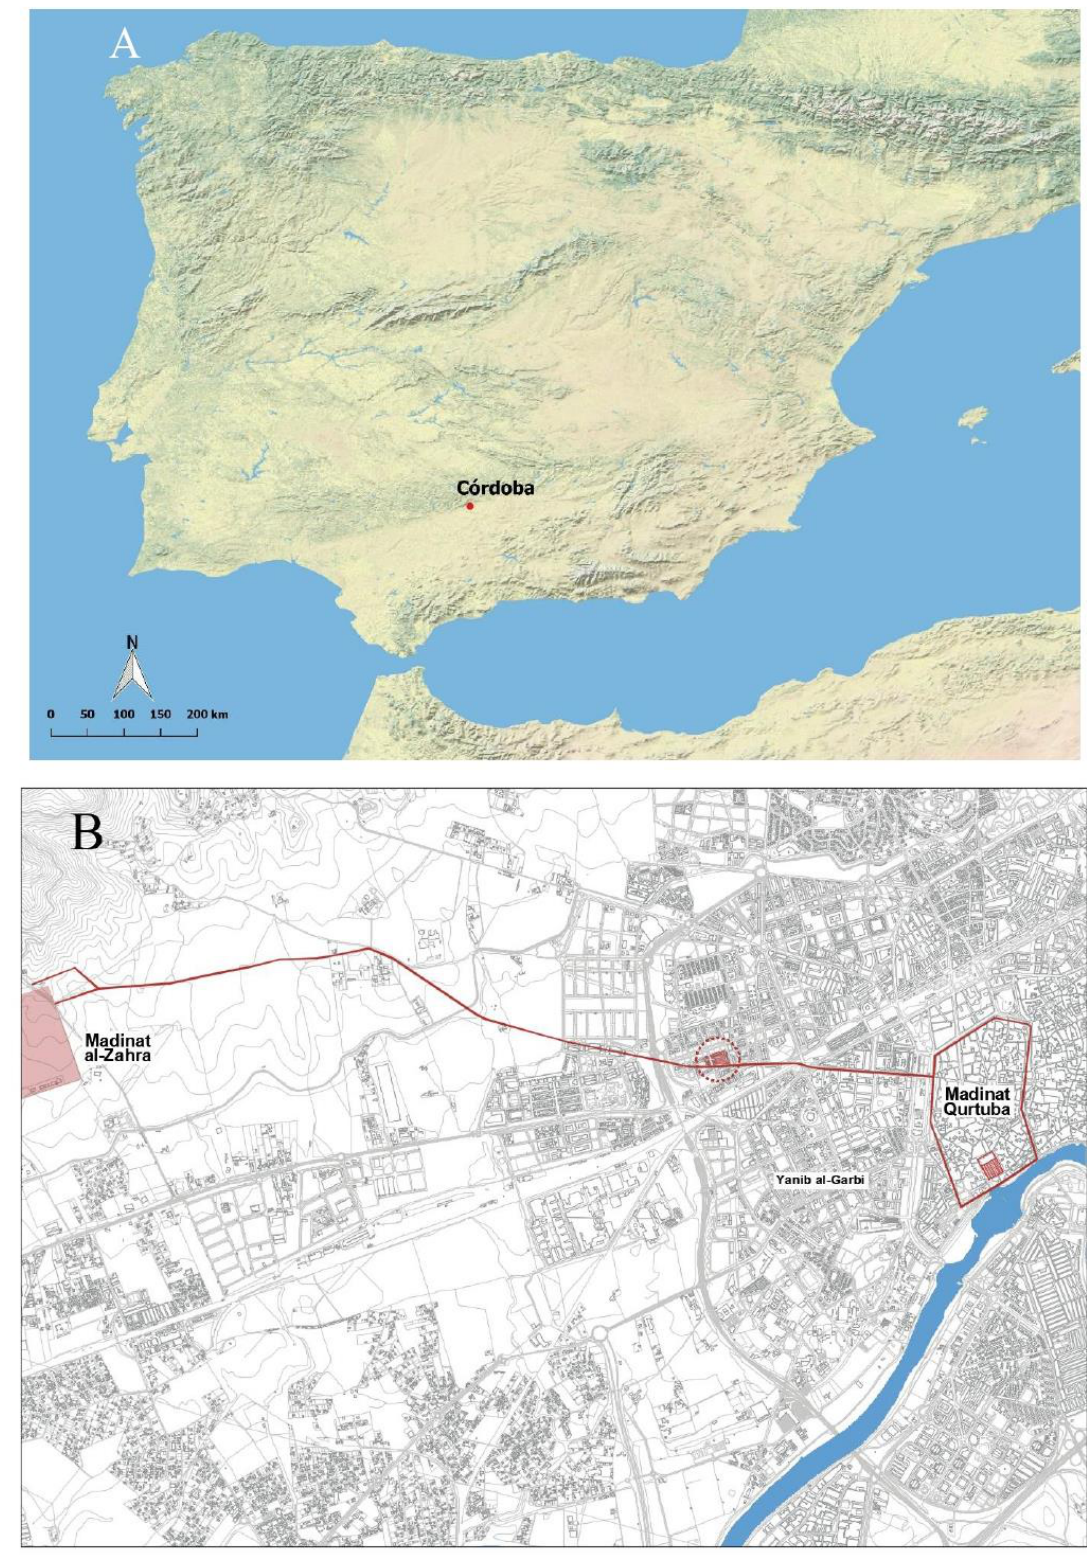
Figure 1. Location map of Córdoba ( A ). Location of the excavation area against the plan of modern Córdoba (Source: Instituto de Estadística y Cartografía de la Junta de Andalucía). In red, the road that skirted the arrabal to the south, which ran from the ʻ Āmir al Qurashi gate to Madīnat al-Zahrā ̛ ( B ).